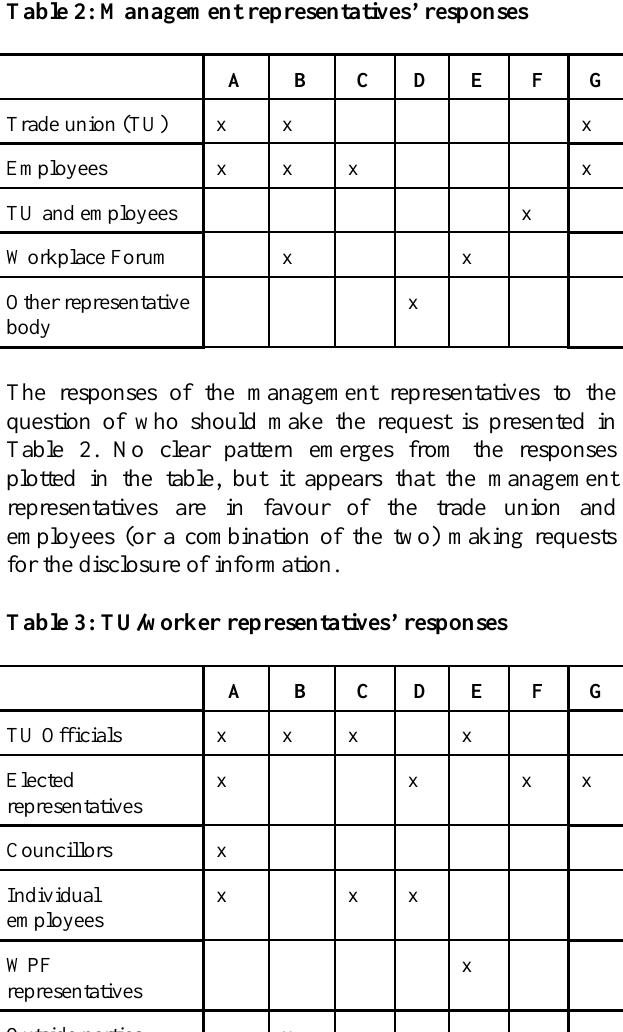
Table 2: Management representatives’ responses